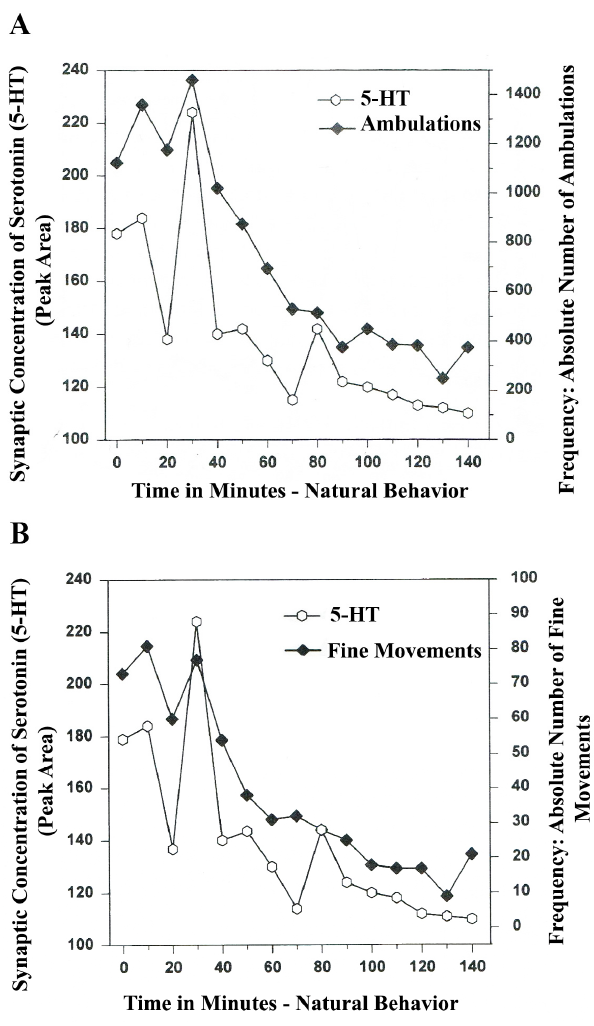
Figure 3. ( A ) Ambulations . Natural neurochemistry and behavior : line graph depicting terminals , DStr , detected in real time, while endogenous 5-HT release (open circles) at A 9 the freely moving, male, Sprague-Dawley laboratory rat is actually behaving, during normal/natural movement (first hour) and subsequent habituation behavior (second hour). ( B ) Fine movements . Natural ( no drug ) neurochemistry and behavior : line graph depicting endogenous 5-HT release (open circles) at A terminals , DStr , detected in real time, while 9 the freely moving, male, Sprague-Dawley laboratory rat is actually behaving, during normal/natural movement (first hour) and subsequent habituation behavior (second